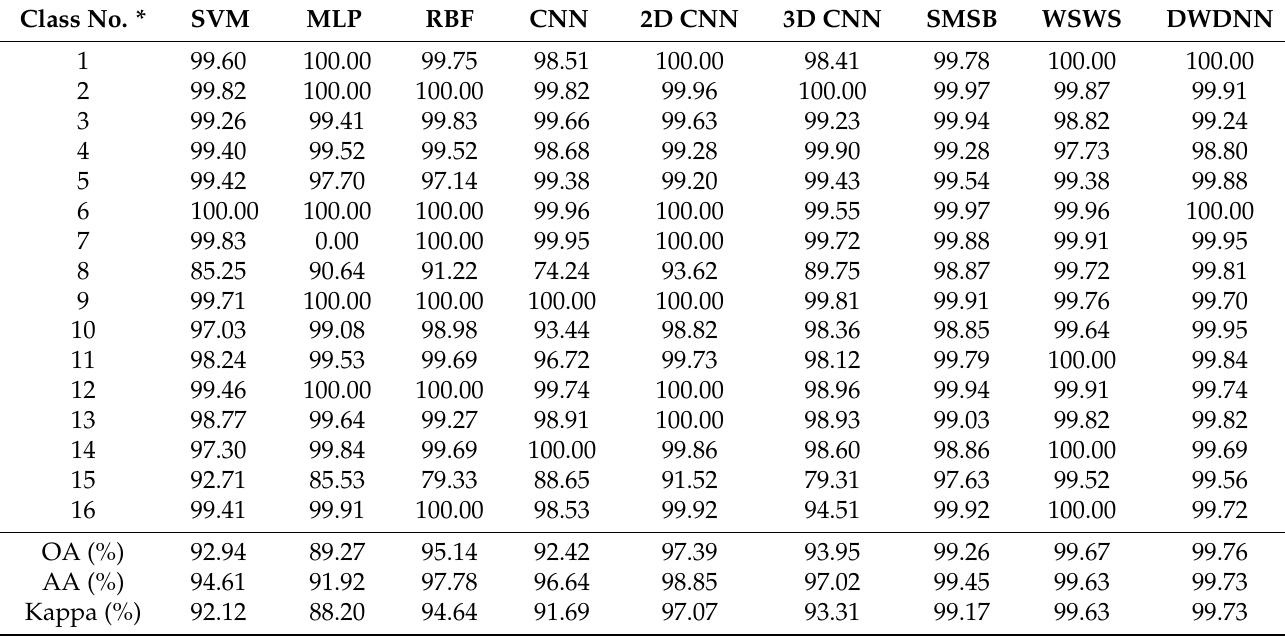
Table 5. Classification results of different methods on the Salinas dataset.